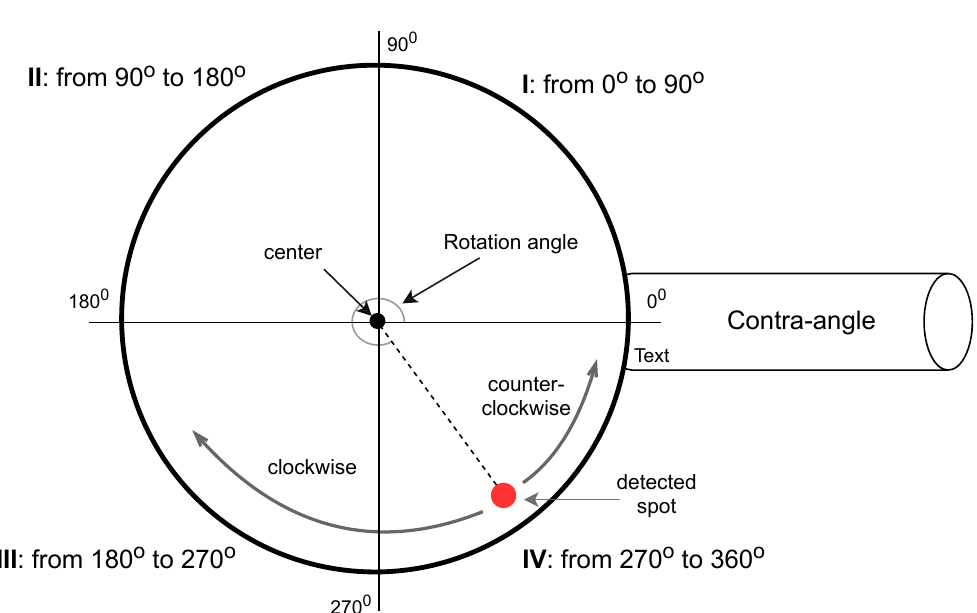
Figure 1. The schematic configuration for the disc in the considered scenario, highlighting the four quadrants of the disc’s